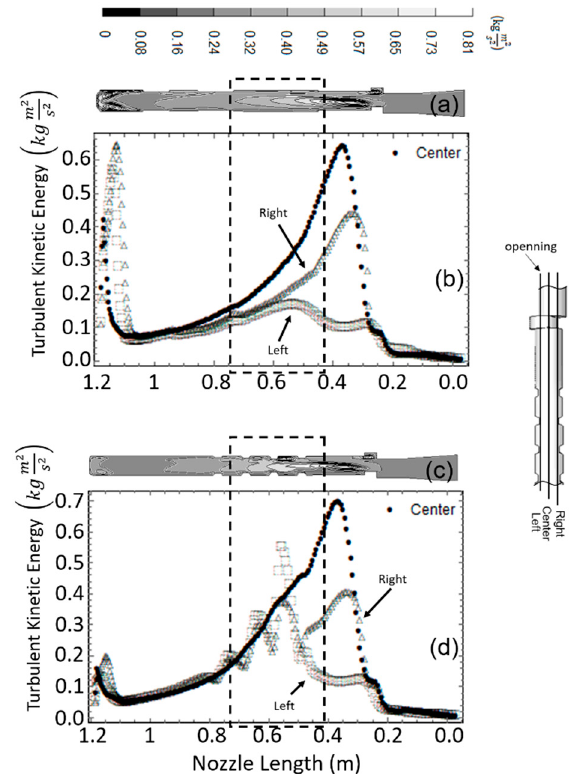
Figure 8. ( a , c ) Contours of turbulent kinetic energy at the central symmetrical plane and Figure 8. ( a) ,( c ) Contours of turbulent kinetic energy at the central symmetrical plane and ( b) ,( d ) ( b , d ) turbulent kinetic energy magnitude calculated in tree lines along both nozzle turbulent kinetic energy magnitude calculated in tree lines along both nozzle lengths.